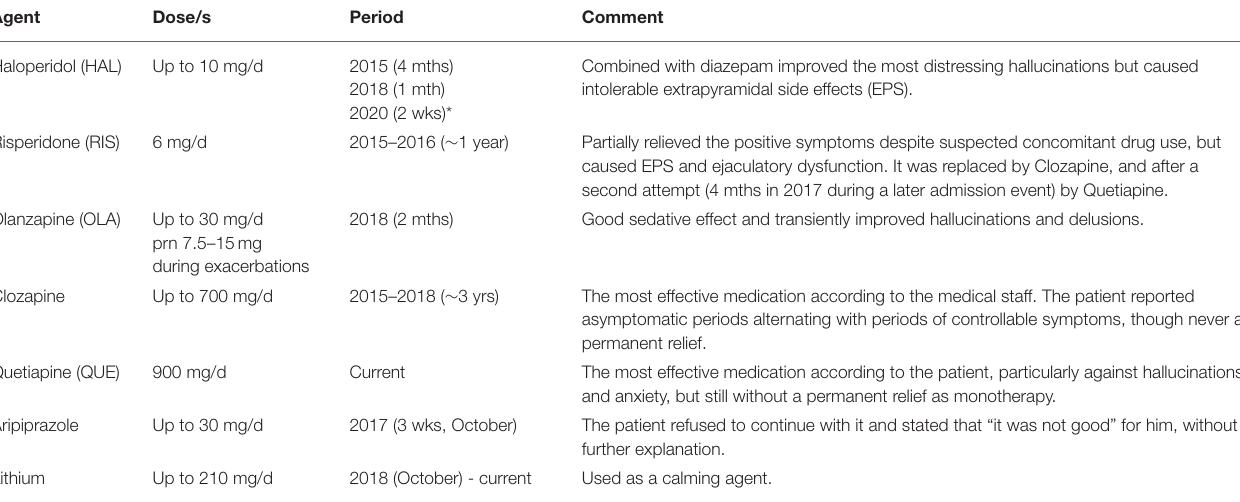
TABLE 1 | Medication history overview (in- as well as outpatient